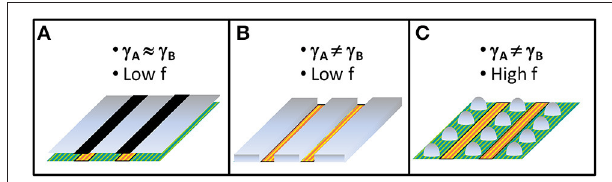
FIGURE 2 | Sketches of the different nanostructures that can be obtained on self-ordered chemical terminations of (001) surface of a perovskite ABO 3 single-crystal. f represents the lattice mismatch, γ A and γ B represent the interfacial energies on AO and BO 2 chemical terminations, respectively. (A) Replication of the chemical terminations by 2D growth in case of low interfacial energies and lattice mismatch. (B) Selective 2D growth only on one chemical termination due to different termination-dependent interfacial energies and low lattice mismatch. (C) Selective 3D growth only on one chemical termination due to different termination-dependent interfacial energies and high lattice